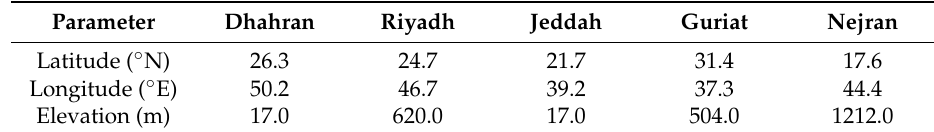
Figure 8. Regional map of Saudi Arabia. Table 1. Geographic data for all sites.